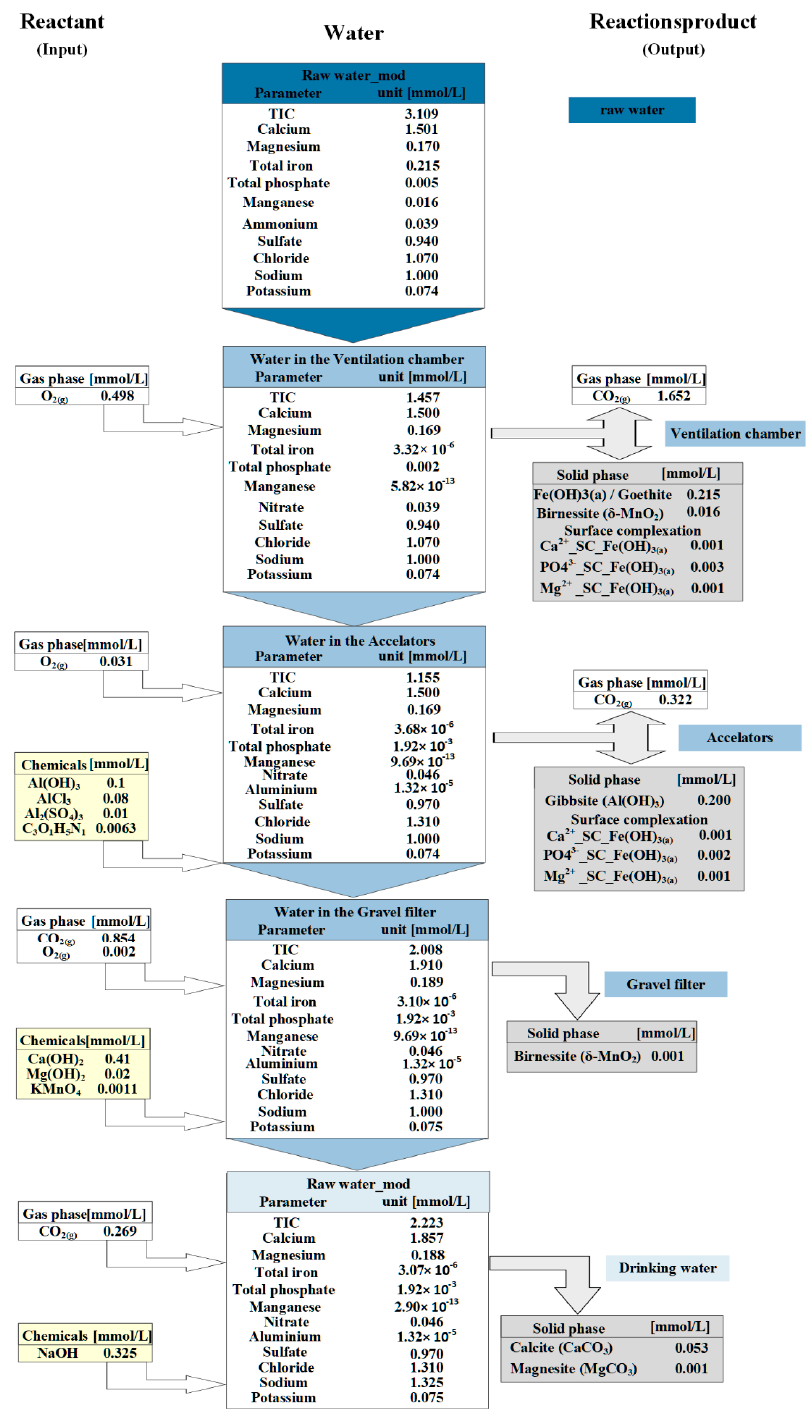
Figure 7. Mass balance of all relevant parameters at each processing stage.